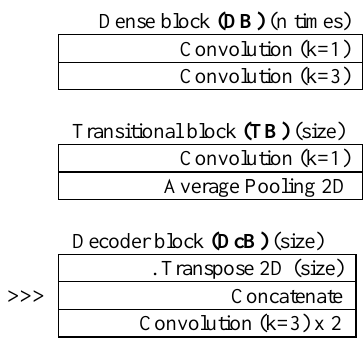
Figure 4 . The k=1 convolution aims at reducing the filters block dimension before the computationally expensive convolution with kernel size of 3 (k=3) (Szegedy et al., 2015). The transition blocks (